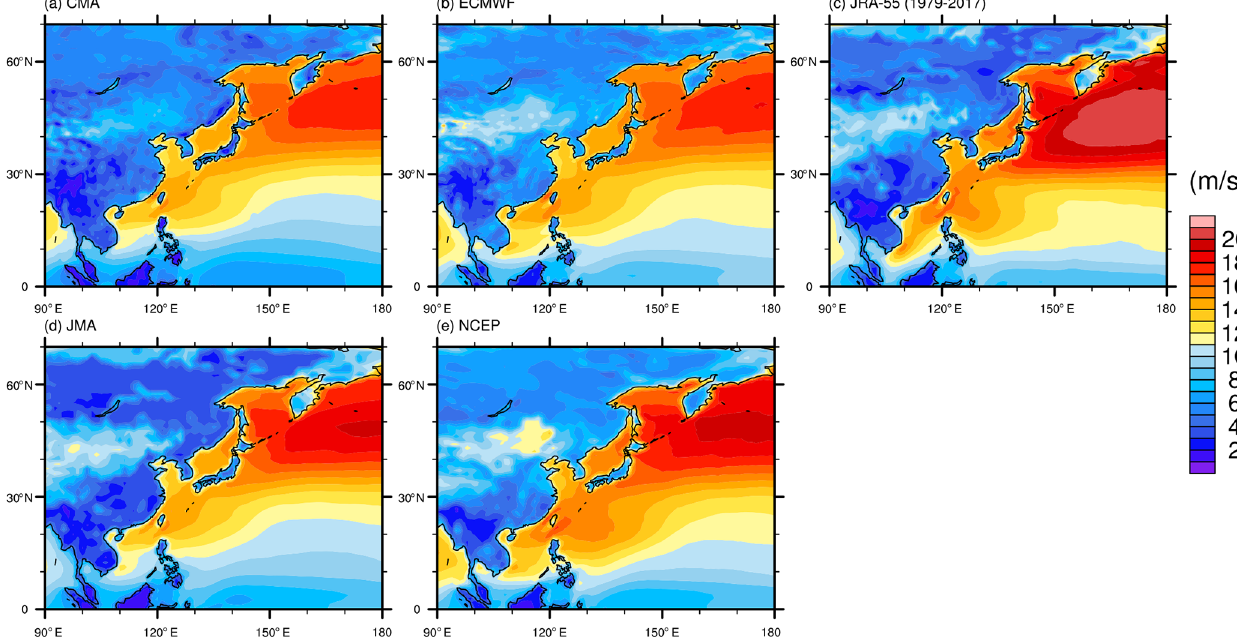
Figure 1. Local 98th percentile wind speed for each grid box in the region for TIGGE: (a) CMA, (b) ECMWF, (d) JMA, (e) NCEP, and (c)